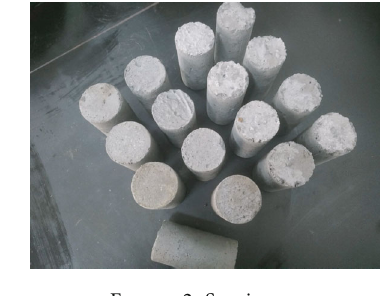
Figure 2: Specimens.